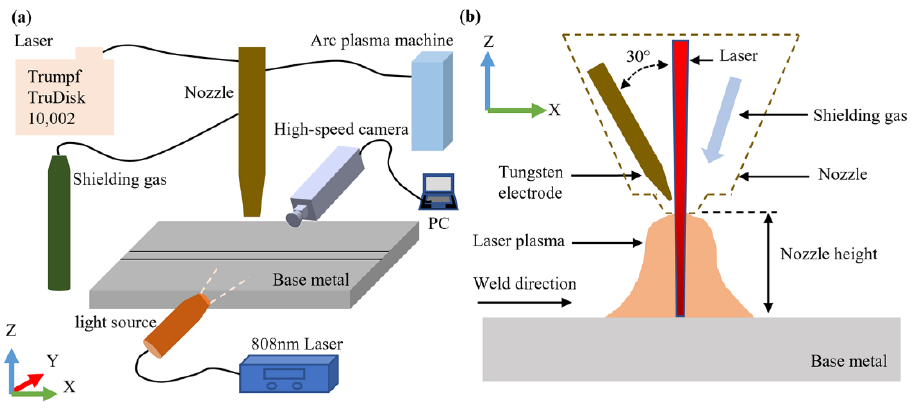
Figure 1. Schematic diagram of HLAW system: ( a ) HLAW equipment; ( b ) composite mode of laser and arc.